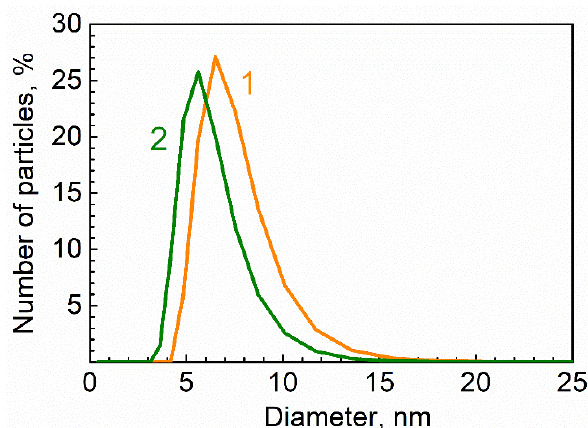
Figure 3. Size distribution of CdSe/ZnS quantum dots stabilized by TOPO (1) and 2-carboxyethyl acrylate (2) molecules.